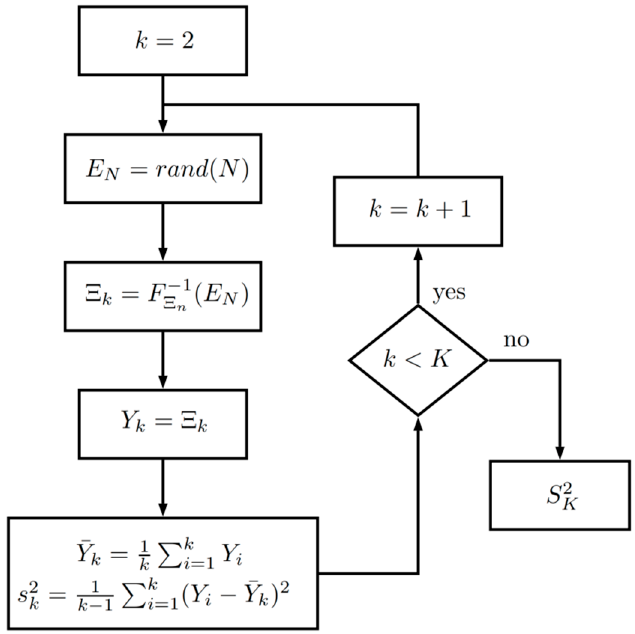
Figure 4. Simulation procedure with the Monte-Carlo method (MMC) to determine the variance s 2